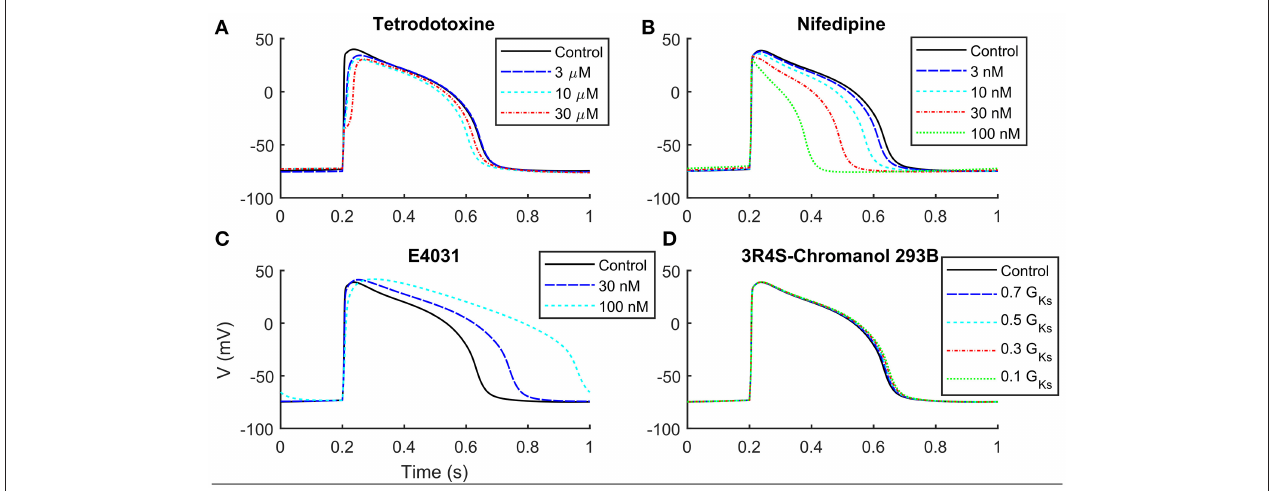
FIGURE 5 | Simulation of current block effects on hiPSC-CMs paced at 1Hz. (A) Tetrodotoxine blocks I Na , slowing down the upstroke phase. (B) Nifedipine blocks I CaL , shortening APD and triangulating AP profile. (C) E4031 blocks selectively I Kr , increasing APD. (D) I Ks block by 3R4S-Chromanol 293B does not affect significantly the AP